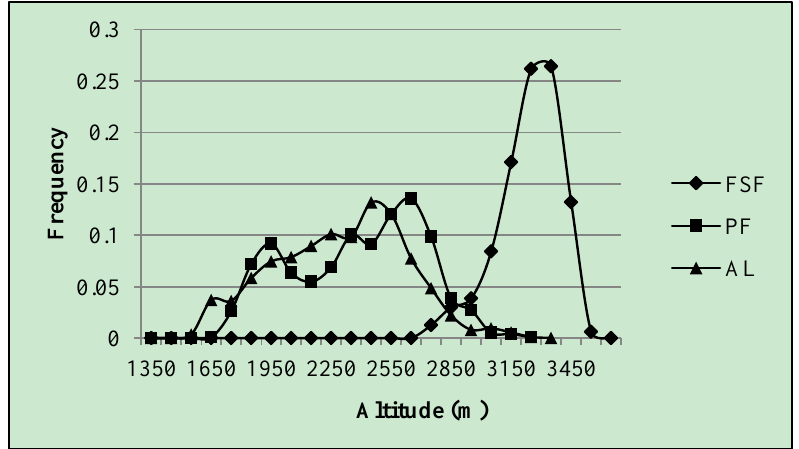
Figure 12. Frequency distribution of DN values for YRT and AL in Landsat TM band 4.